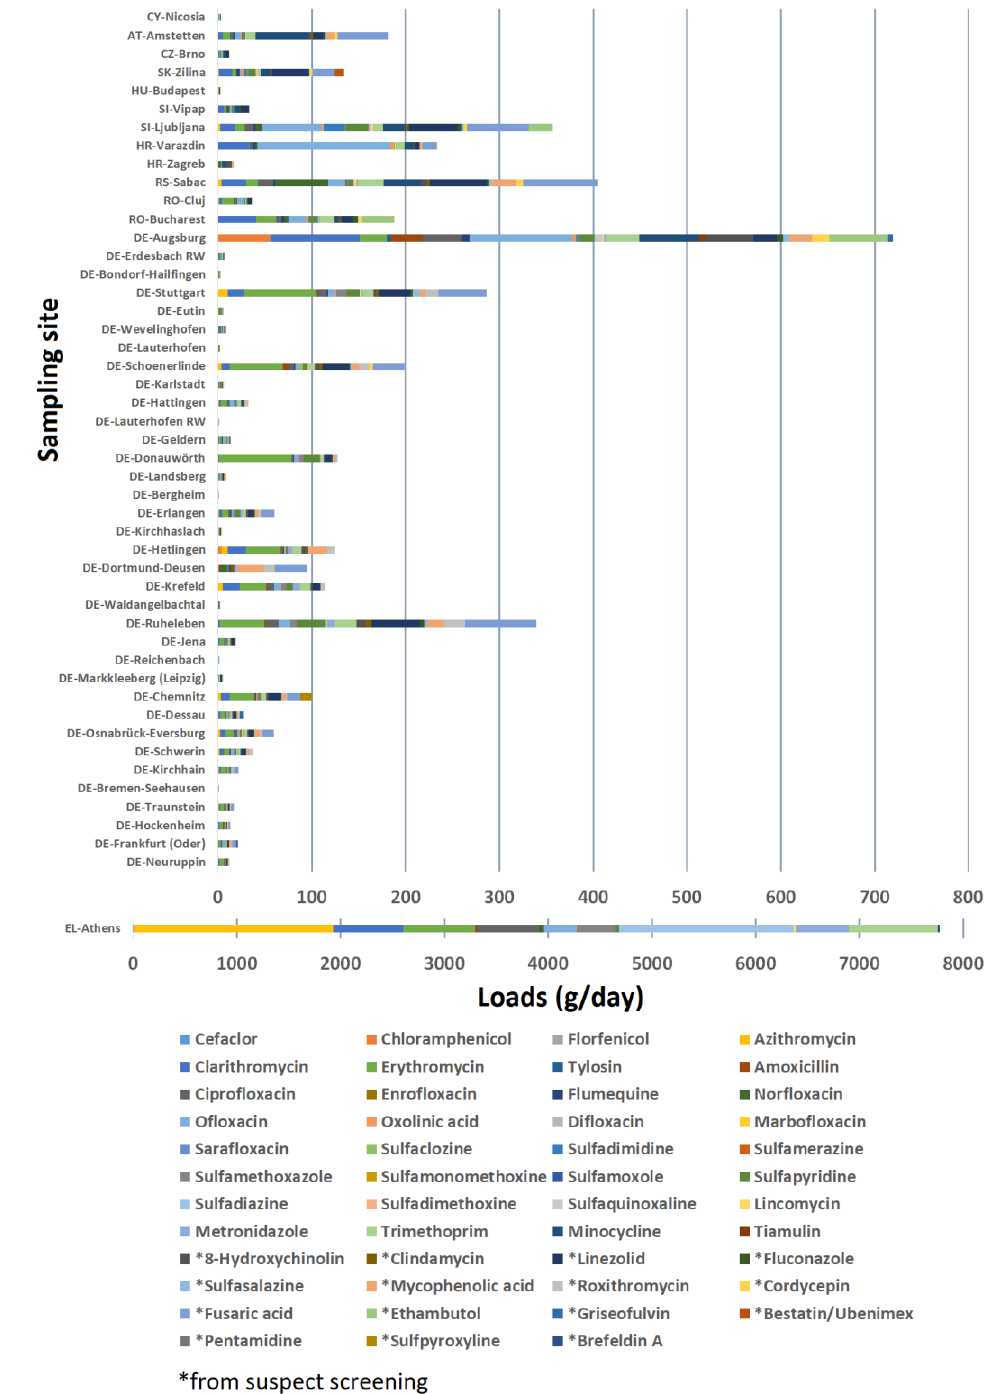
Figure 2. Stacked bar plot of antibiotic loads into freshwater ecosystems expressed in gram per day (Germany DE, Romania RO, Serbia RS, Croatia HR, Slovenia SI, Hungary HU, Slovakia SK, Czechia CZ, Austria AT, Cyprus CY, Greece EL).